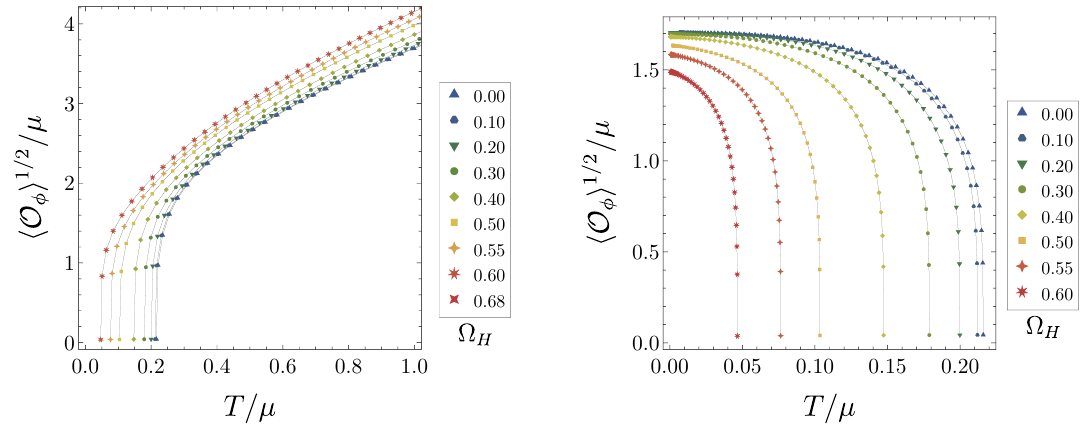
Figure 18 . Left : condensate against the temperature, for families of rotating hairy black branes with di(cid:11)erent values of (cid:10) H . The critical temperature T c , at which the hairy solutions (cid:12)rst appear, decreases with (cid:10) H . Right : expectation value of the dual operator as a function of temperature for a phenomenological Abelian-Higgs model, as a scale invariant quantity, for various values of the horizon velocity (cid:10) H